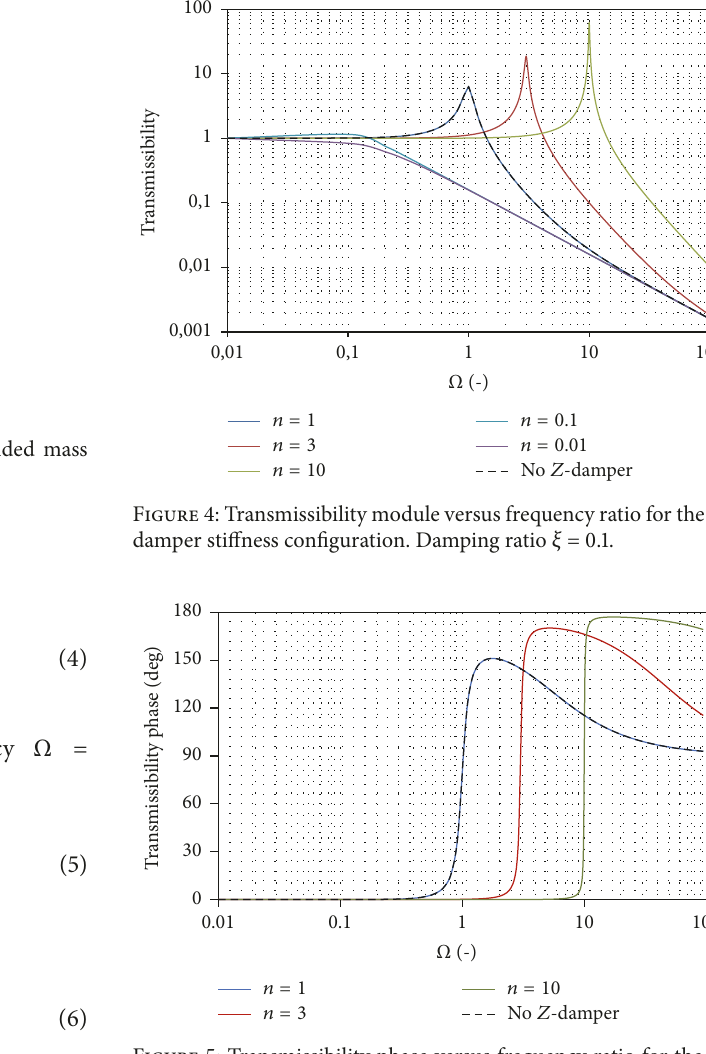
Figure 5: Transmissibility phase versus frequency ratio for the 𝑍 - damper stiffness configuration. Damping ratio 𝜉 =